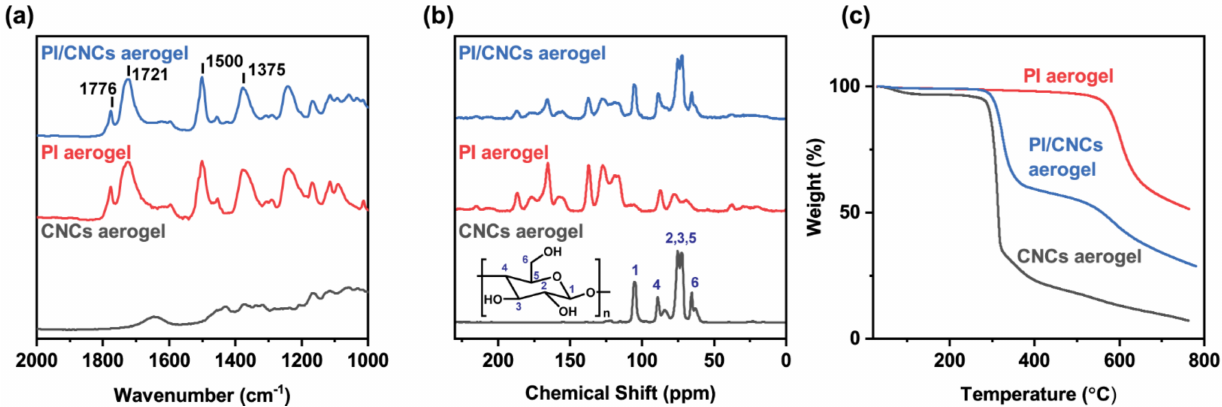
Figure 4. ( a ) FTIR spectra of the aerogels. ( b ) Solid-state 13 C NMR spectra of the aerogels. ( c ) TGA curves of aerogels. The PI/CNC aerogel was prepared by using 6.5 wt%